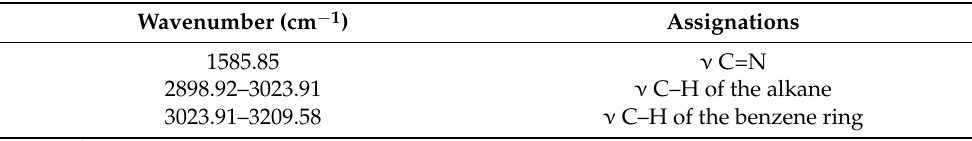
Table 3. Assignations of the bands of the aromatic molecule vibration